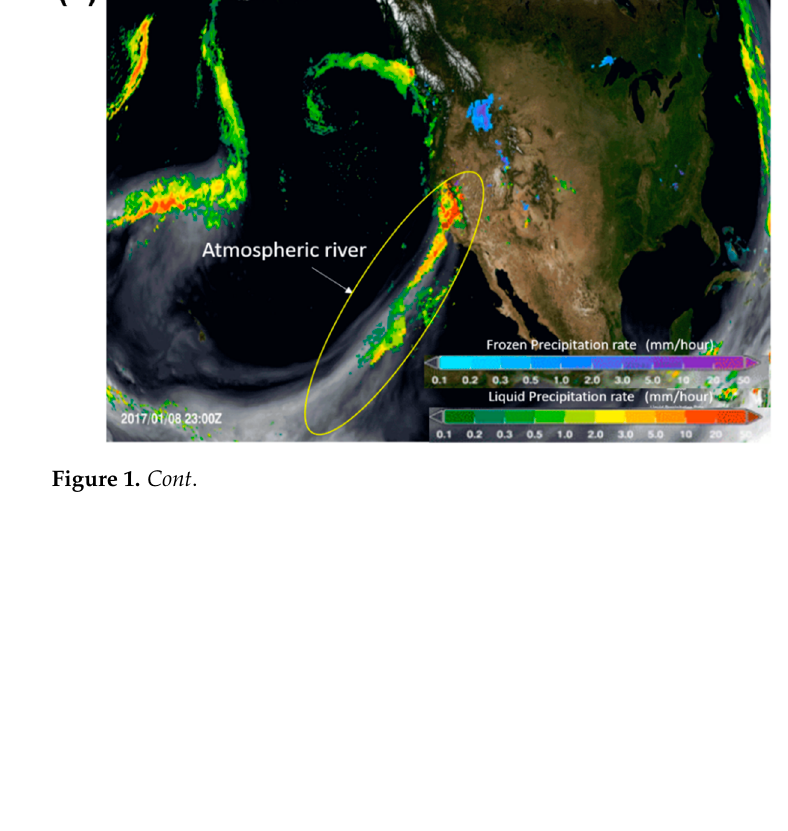
Figure 1. ( a ) The example of GPM precipitation for the 8 January 2017 AR event, striking the western U.S (figure credit: NASA GPM [23]). ( b ) The elevation map of the western U.S. and snowpack site (Peterson Flat (41.3° N, 122.5° W), Rubicon Peak (39.0° N, 120.1° W, Carson Pass (38.7° N, 120.0° W), and Charlotte Lake (36.8° N, 118.4° W)) in the western U.S. The blue box refers to the AR character- istic study (A–F) region and snowpack observation sites (yellow dot and arrows). 2. Data and Methods 2.1. Data We utilized a long-term multiplatform dataset including reanalysis, satellite, and lo- cal observation. Our study regions cover the eastern Pacific and western U.S; for regional AR and SWE analysis, we focus on the local sites, but for synoptic scale analysis, we in- clude the eastern Pacific and the western U.S. (160–100° W, 30–50° N). The study period spans the whole months of the year, but we focused on October through April for synoptic structure and AR characteristic analysis because precipitation and moisture transport as- sociated with dynamic processes over the western U.S. is most active during that period. The individual dataset we used in this study are described in the following subsections. 2.1.1. MERRA2 Meteorological variables analyzed in this study were collected from NASA’s Mod- ern-Era Retrospective analysis for Research and Applications version 2 (MERRA2) [24,25], including sea level pressure (SLP), geopotential height at 1000 hPa and 500 hPa, air